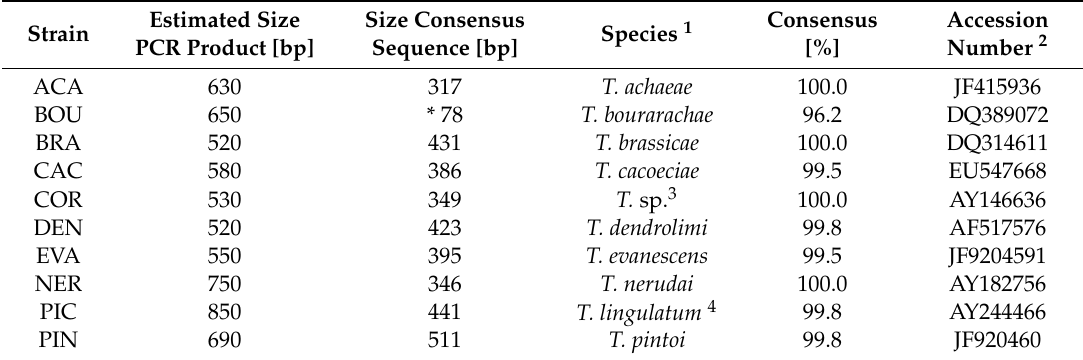
Table 2. Analysis of the ITS2 sequence of selected Trichogramma strains. Fragment sizes of PCR products were estimated based on the result of the gel